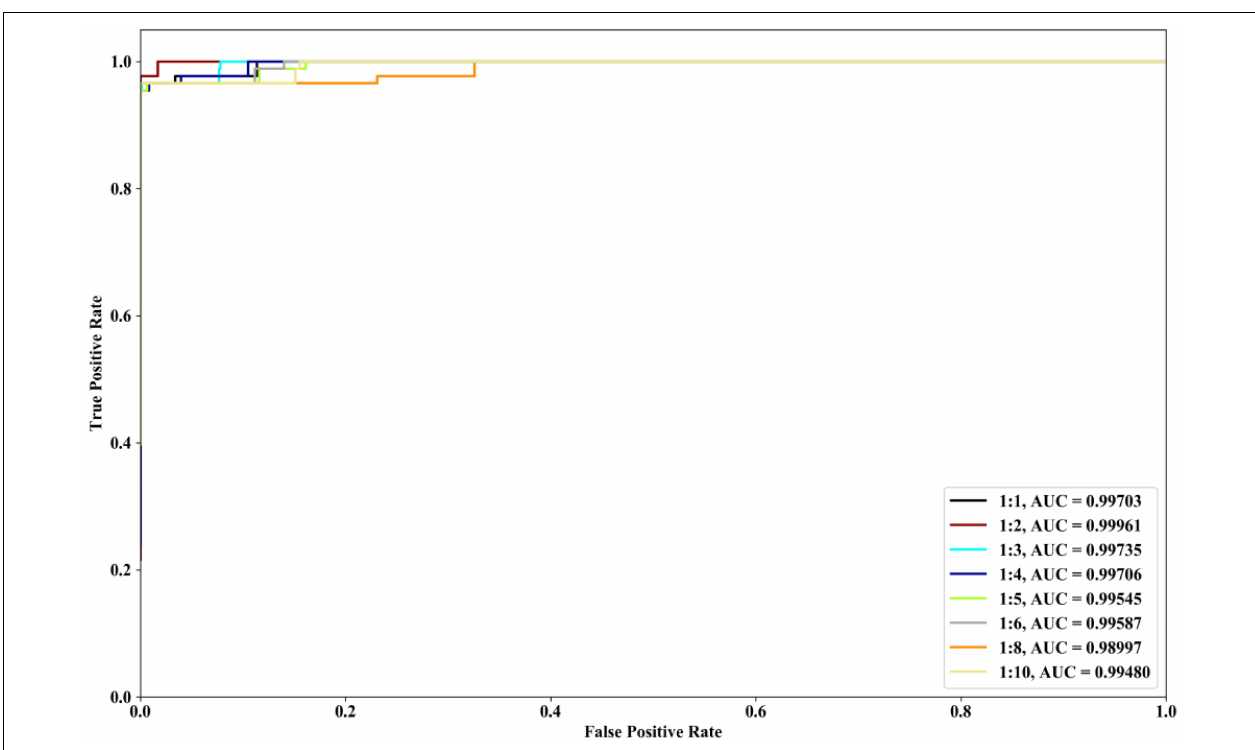
FIGURE 7 | Performances of our method with COVID-19 dataset and the different ratios of positive and negative